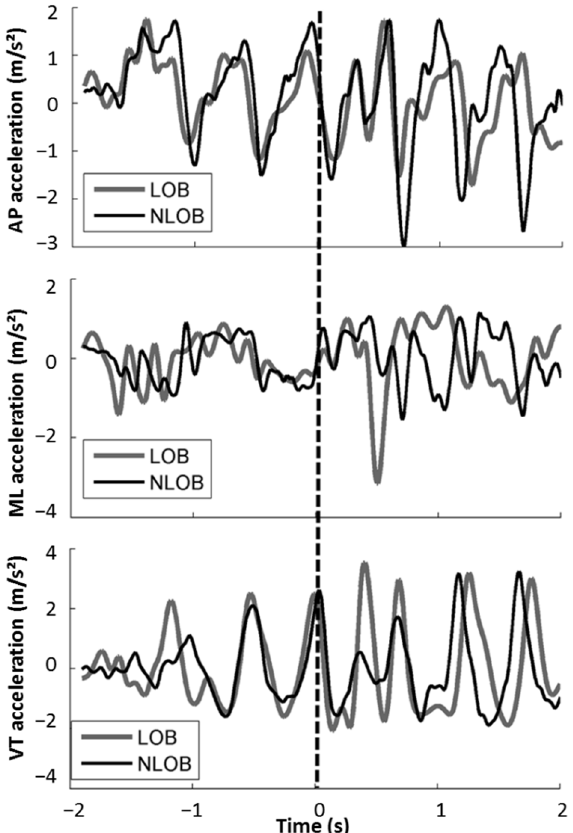
Figure 1. One sample of three-axis acceleration time-series curves for an LOB trial (gray) and an NLOB trial (black), the time of 0 s indicates the onset of slip perturbation. AP indicates anterior-posterior direction, ML indicates mediolateral direction, and VT indicates vertical direction.